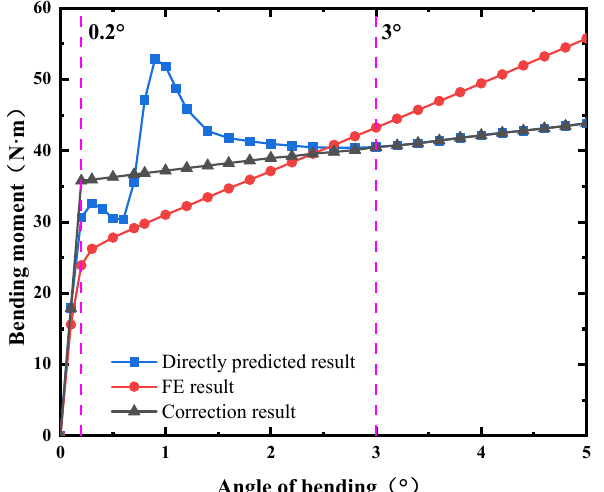
Figure 13. Method introduction.